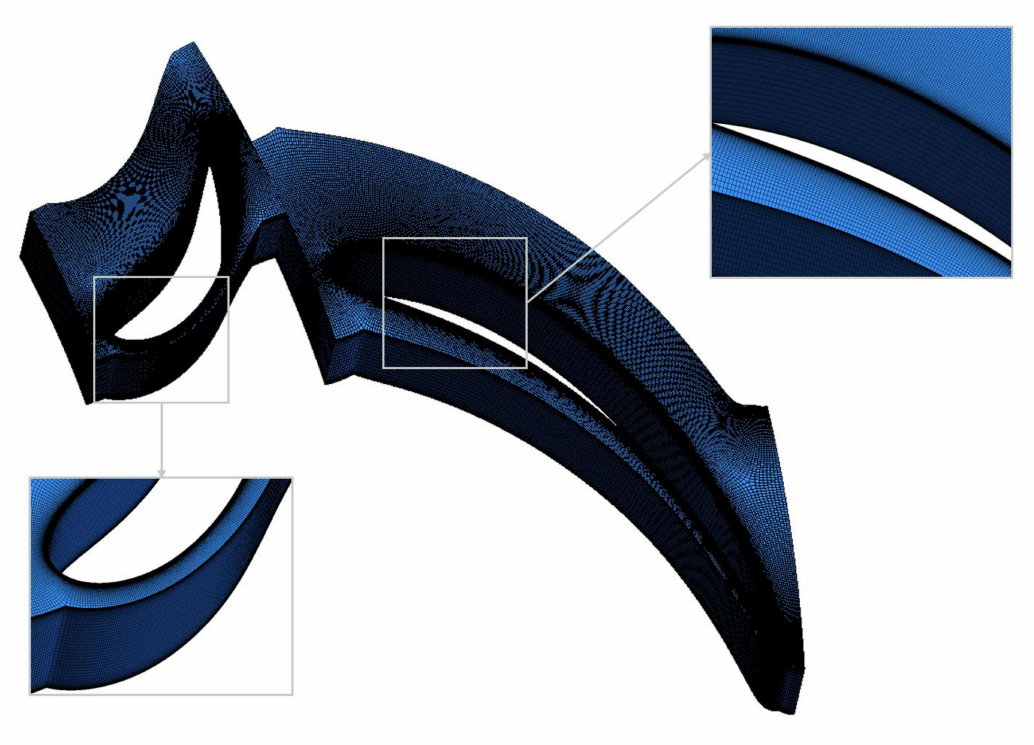
Figure 6. One-passage geometry of the radial outflow turbine.